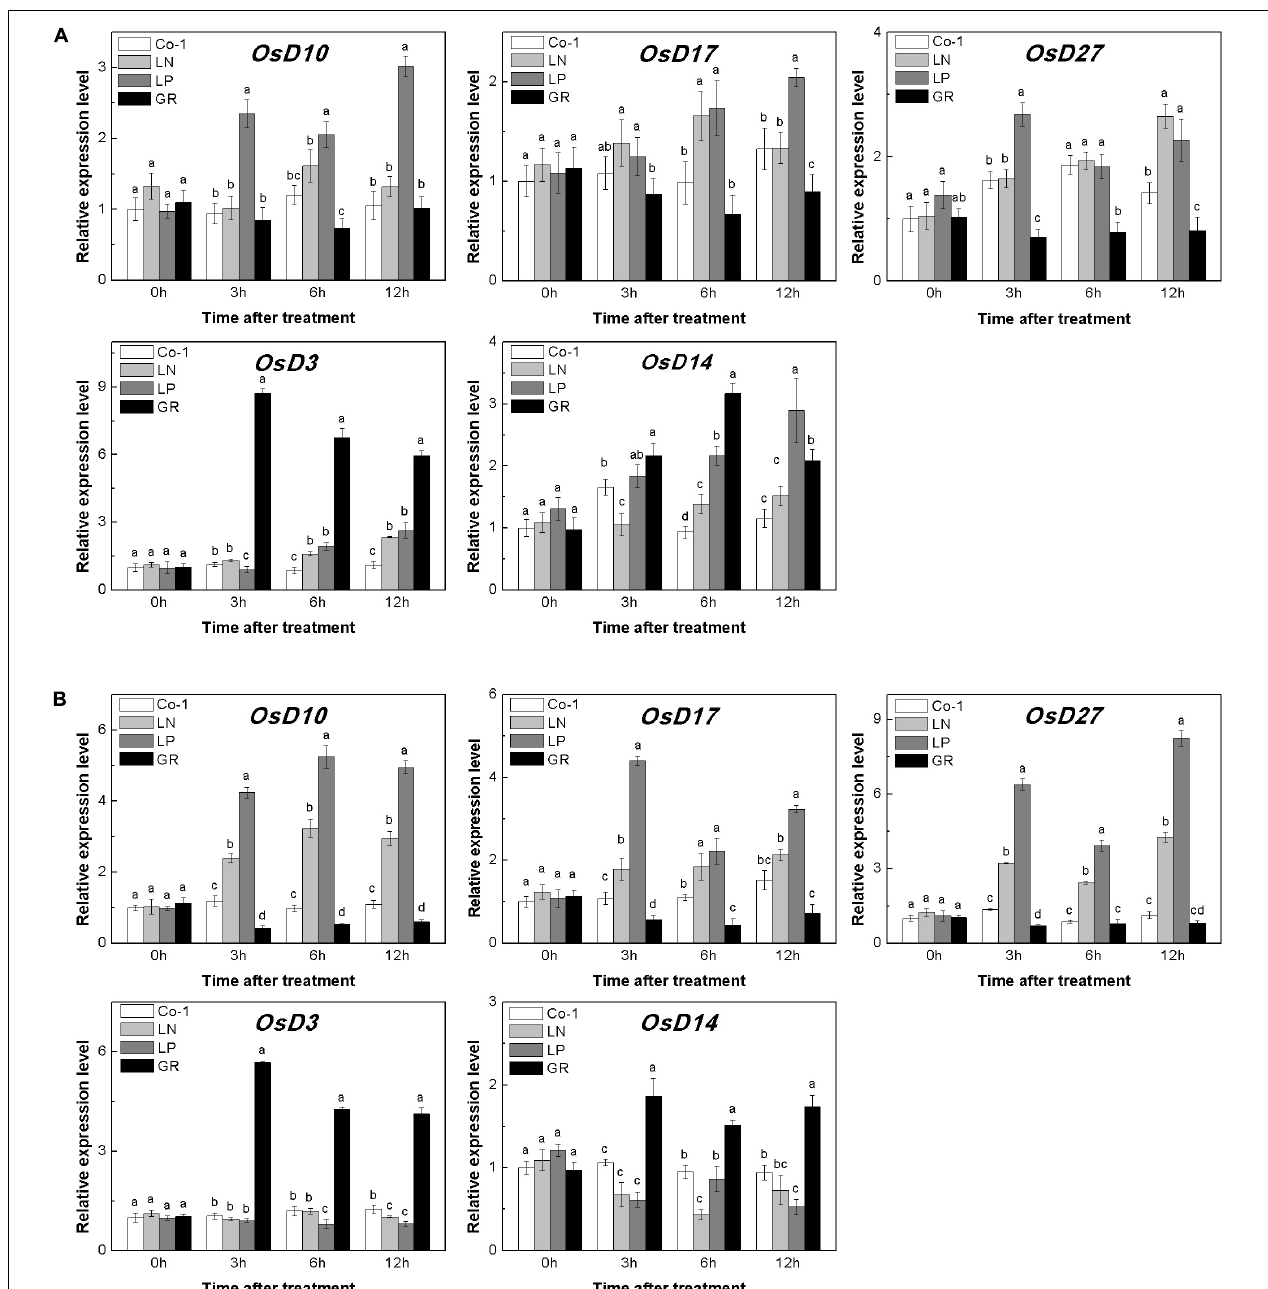
FIGURE 3 | Expression patterns of OsD10 , OsD17 , OsD27 , OsD3, and OsD14 ST biosynthesis and signaling genes in rice tiller buds (A) located at the fifth leaf axils and root (B) expressed in response to the treatment. Total RNA was isolated from less than 0.1 g of buds and nodes each time. β -Actin was used as a reference gene. The value obtained from the control treatment at 0 h after treatment was arbitrarily set at 1.0. Expression of each gene at 0, 3, and 6 h after treatments is represented relative to the Co-1 treatment at 0 h. Quantitative real-time PCR was performed in triplicate (three biological replicates), and mean values with SD are